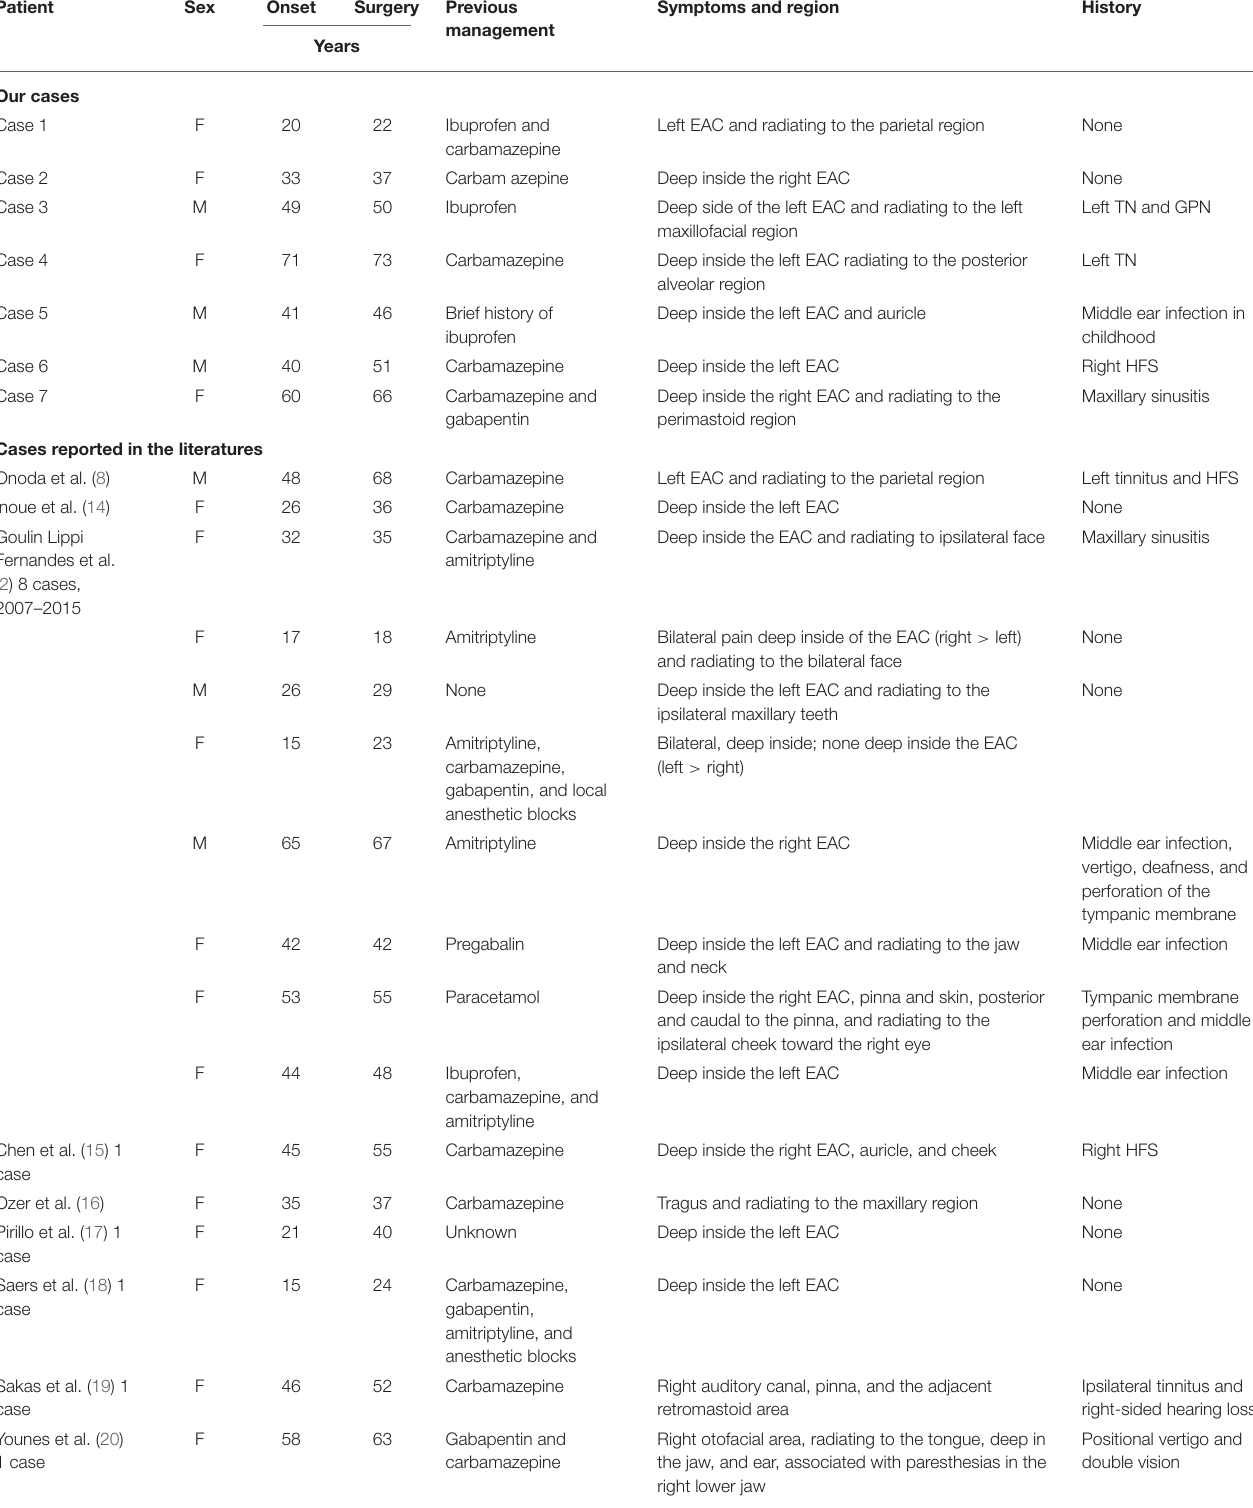
TABLE 1 | Patients’ baseline